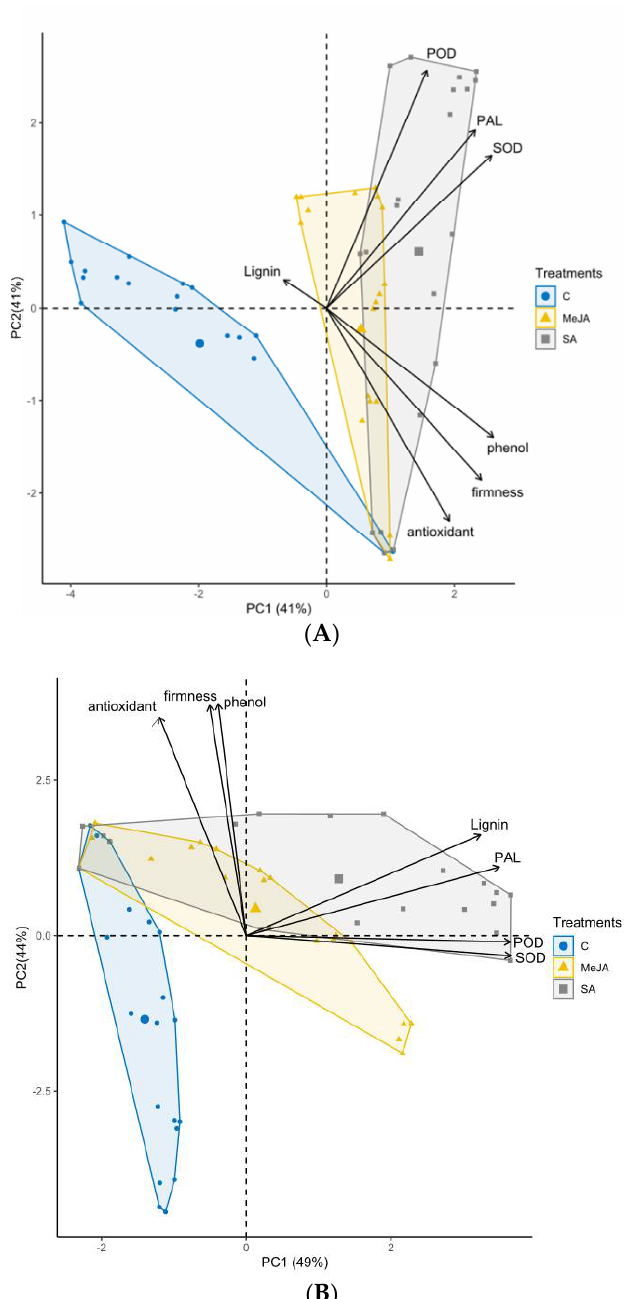
Figure 6. Two biplots of PCA (principal component analyses) conducted separately for Monilinia laxa -inoculated ( A ) and non-inoculated ( B ) apricot fruits (cultivar ‘Bergarouge’) on the measured fruit quality parameters: FF, fruit firmness; LC, lignin content; TSPC, total soluble phenol content; TAC, total antioxidant capacity; PAL, phenylalanine ammonia-lyase activity; SOD, superoxide dismutase activity; and POD, peroxidase activity. C: control; MeJA: MeJA, 0.4 mmol L −1 ; SA: SA, 2 mmol L −1 ; 95% ellipses.